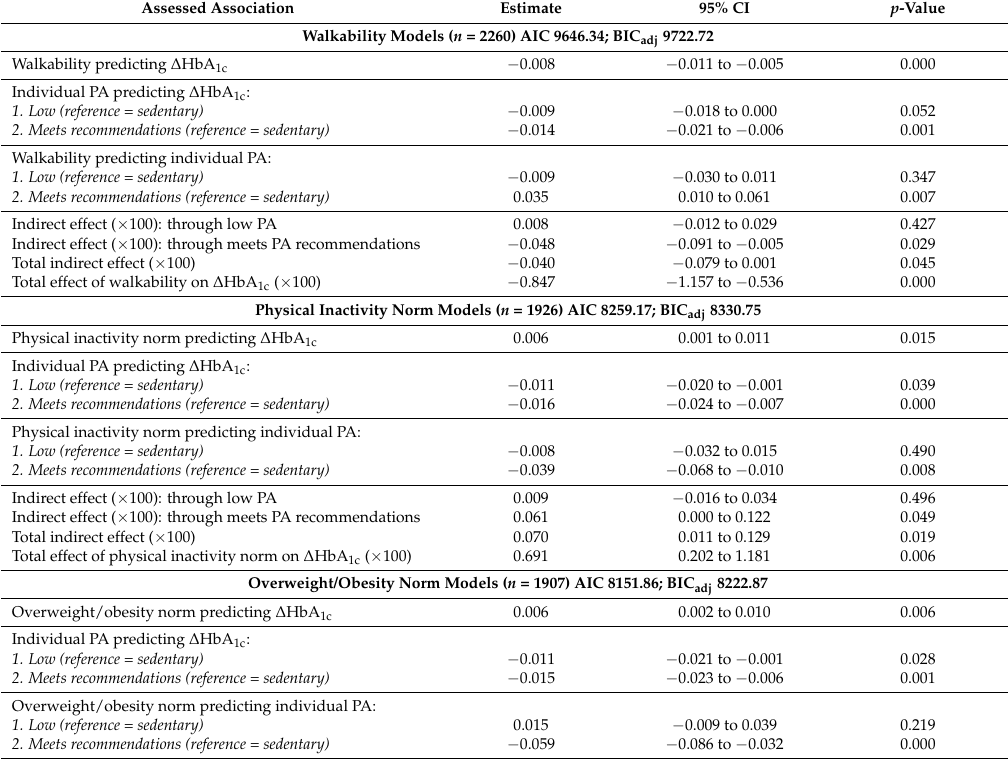
Table 3. Direct and indirect effects of environmental exposures on change in HbA 1c 1